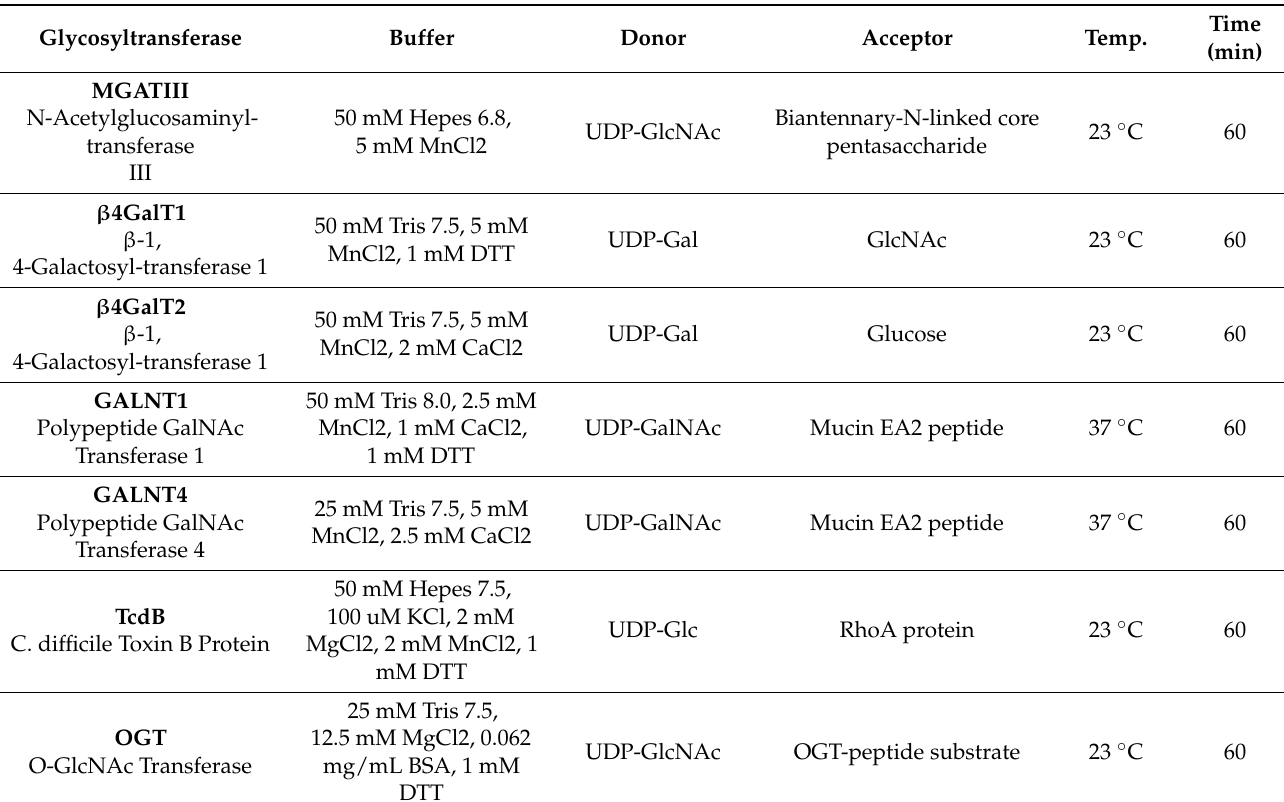
Table 2. Buffers and substrates used for the Glycosyltransferase